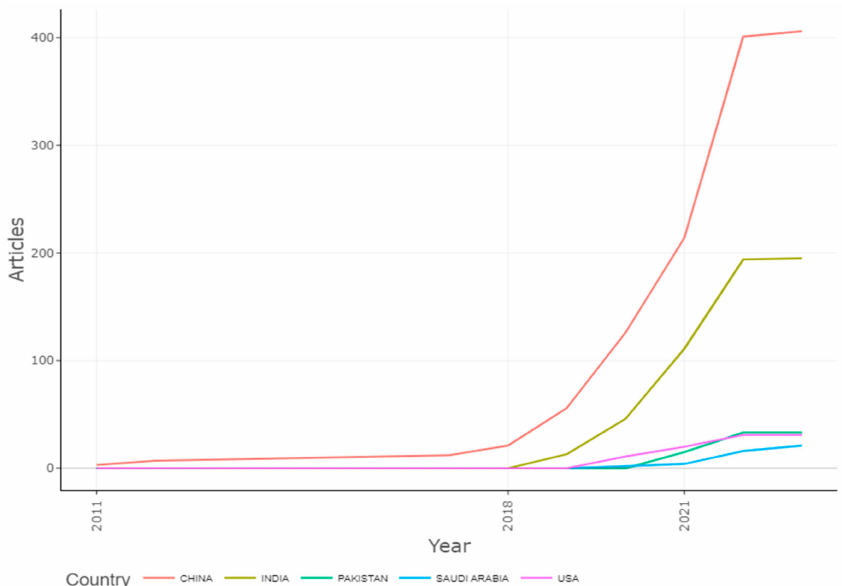
Figure 18. Country’s Production Overtime of Apple Leaves Disease. Data access information source: http://www.scopus.com (accessed on 14 September